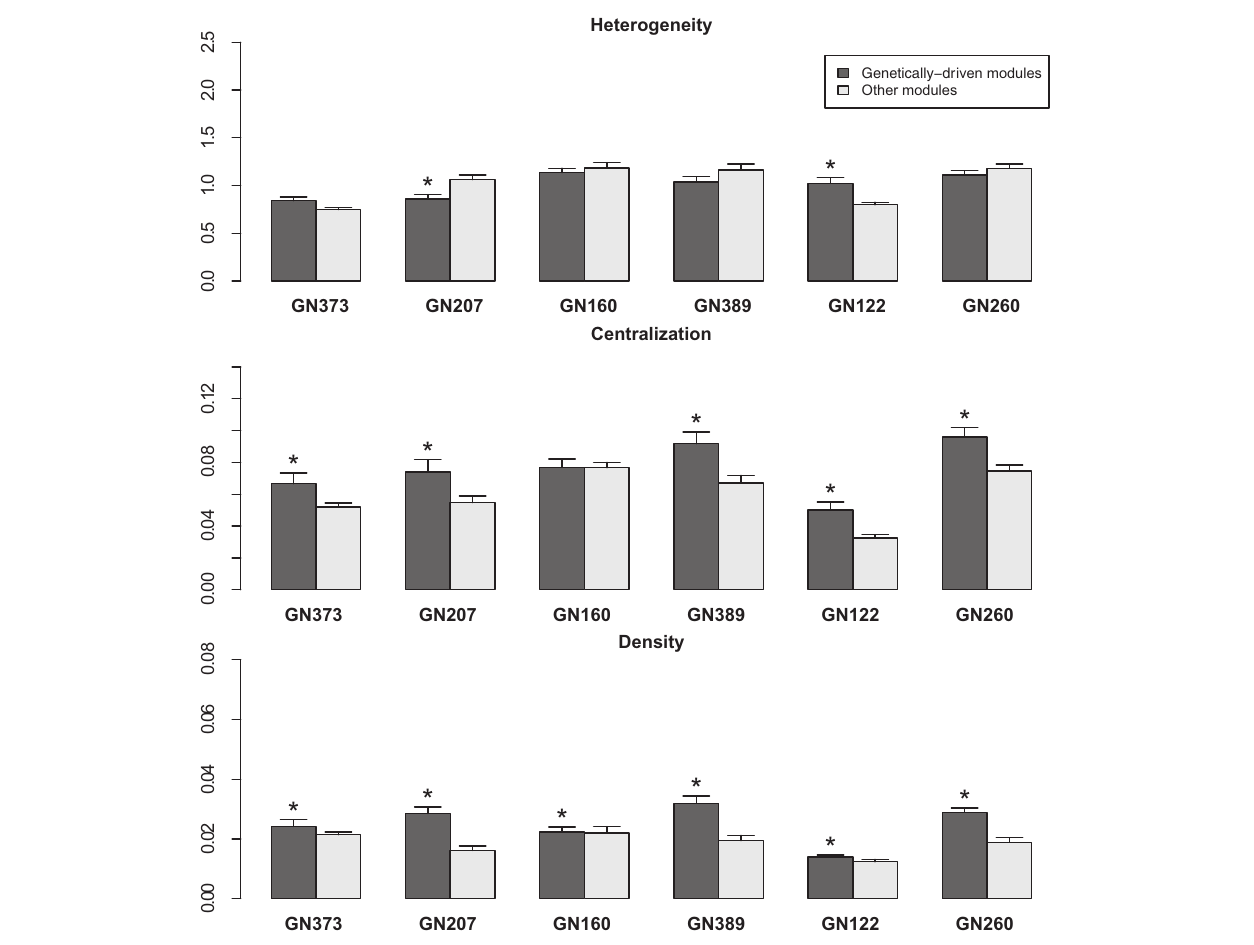
FIGURE 2 | The bar graphs represent the heterogeneity, centralization and density values (mean ± SD) of modules within networks from the 6 tested discovery datasets. Black bars: “genetically-driven” modules; gray bars: other modules. ∗ P < 0 . 05 (Wilcoxon Signed Rank